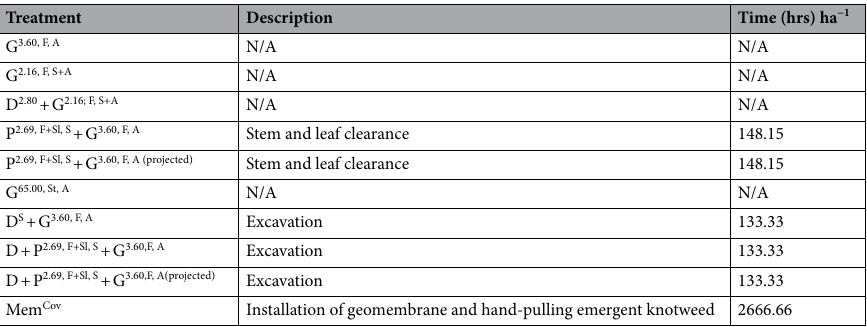
Table 4. Data inputs for physical components of Japanese knotweed treatments. N/A = not applicable as treatments did not include physical management methods.